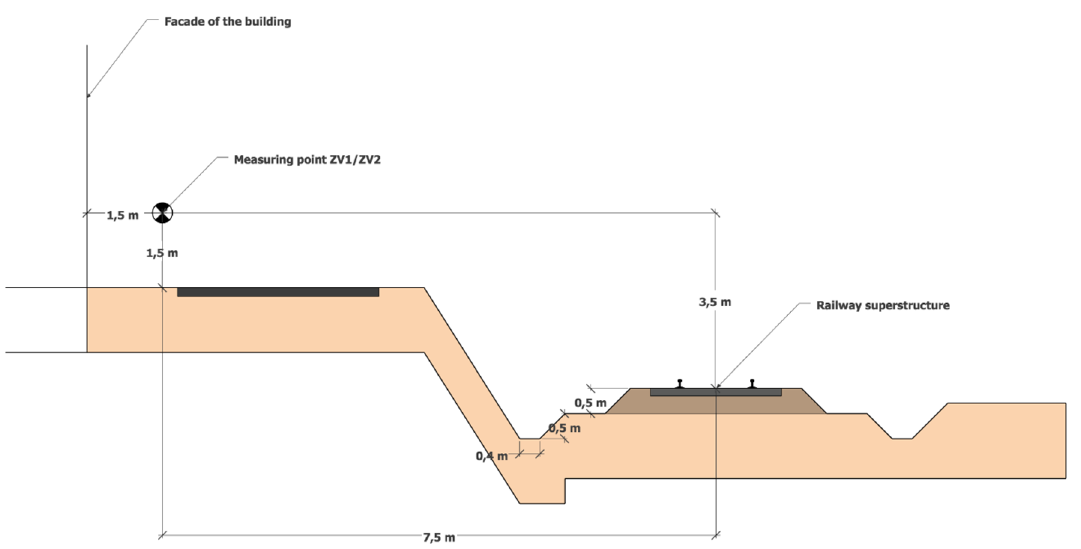
/ ZV2 with regard to the railway